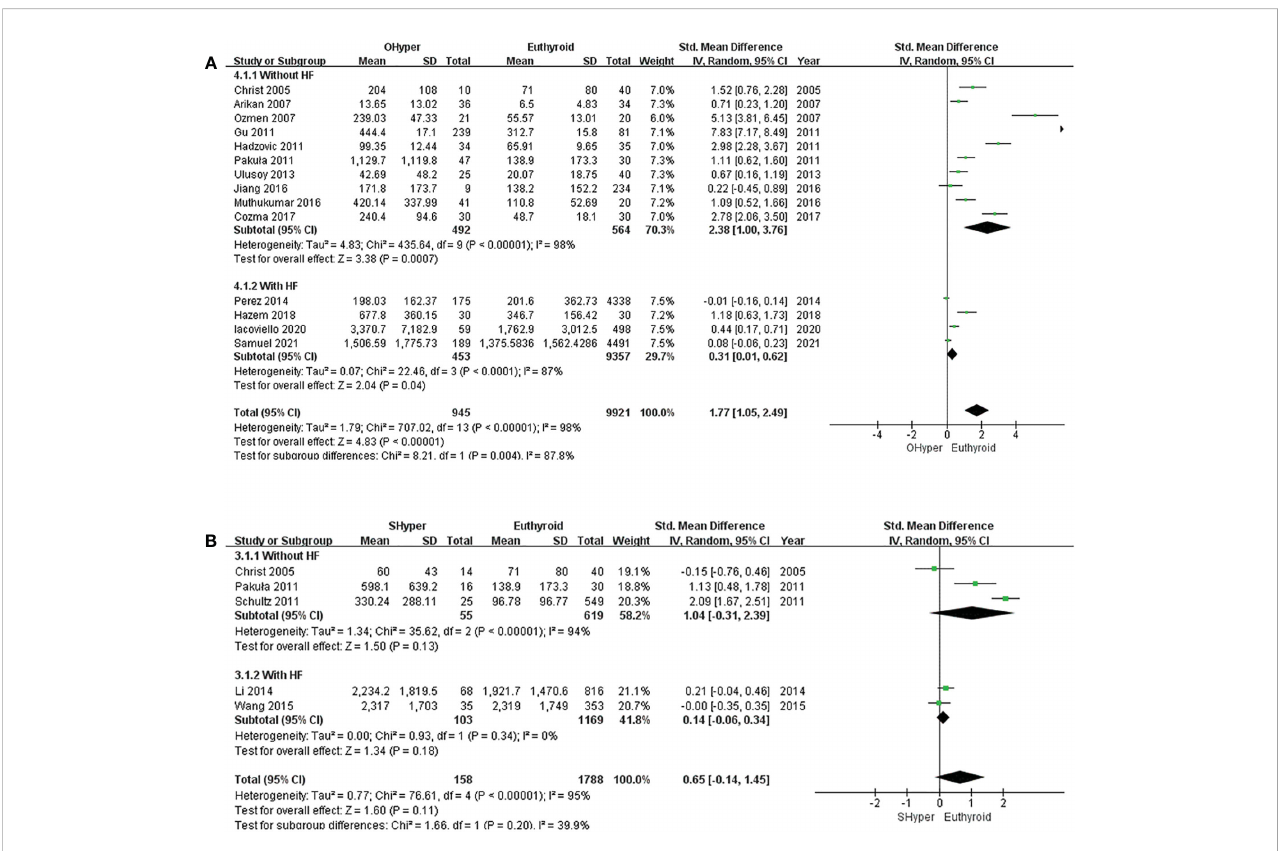
FIGURE 2 Forest plot of the NT-proBNP levels in patients with (A) OHyper and euthyroid subjects; (B) SHyper and euthyroid